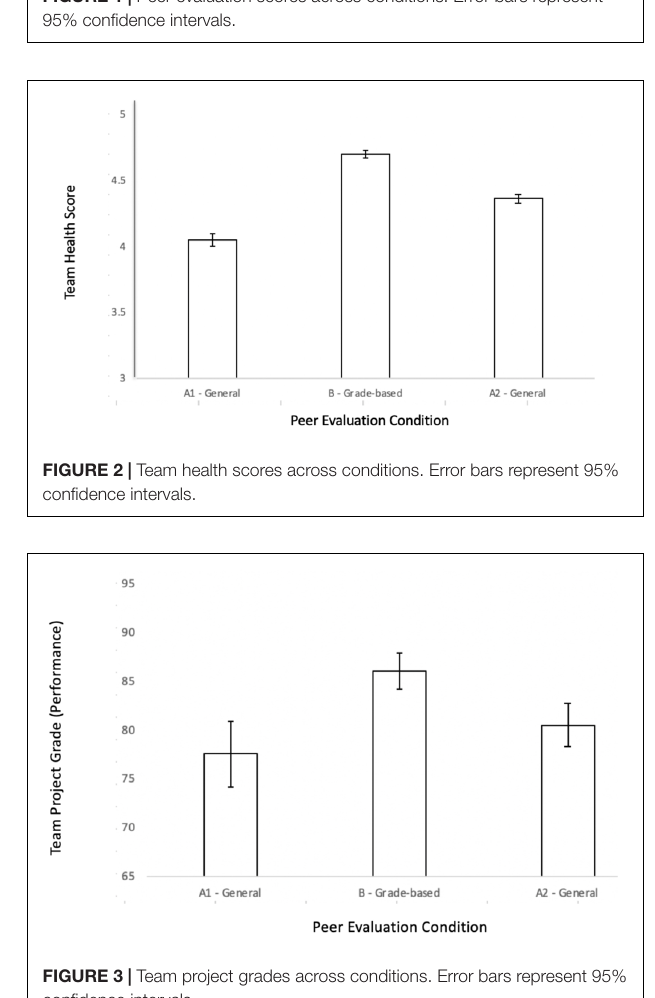
FIGURE 3 | Team project grades across conditions. Error bars represent 95% confidence